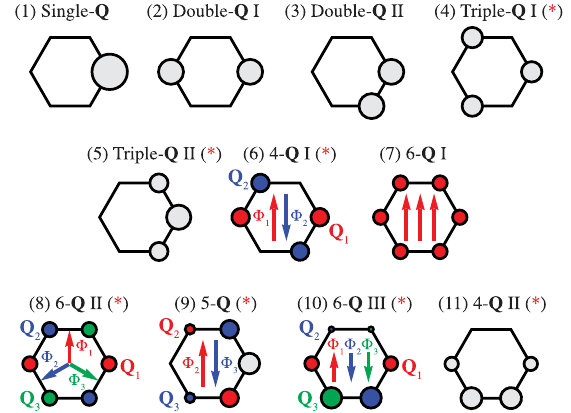
FIG. 5 Schematic condensate distribution in momentum space for the single- and multi- Q states that appear at the field-induced QCP. The arrows representing Φ states with some conditions on Φ vortex crystals (see